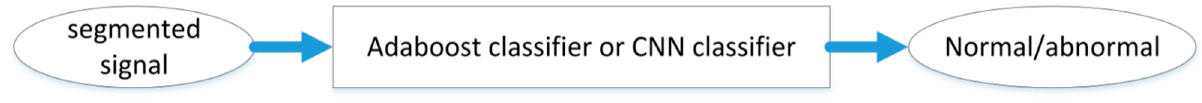
Figure 7. Diagram of the proposed classification method: Adaboost classifier and CNN classifier.